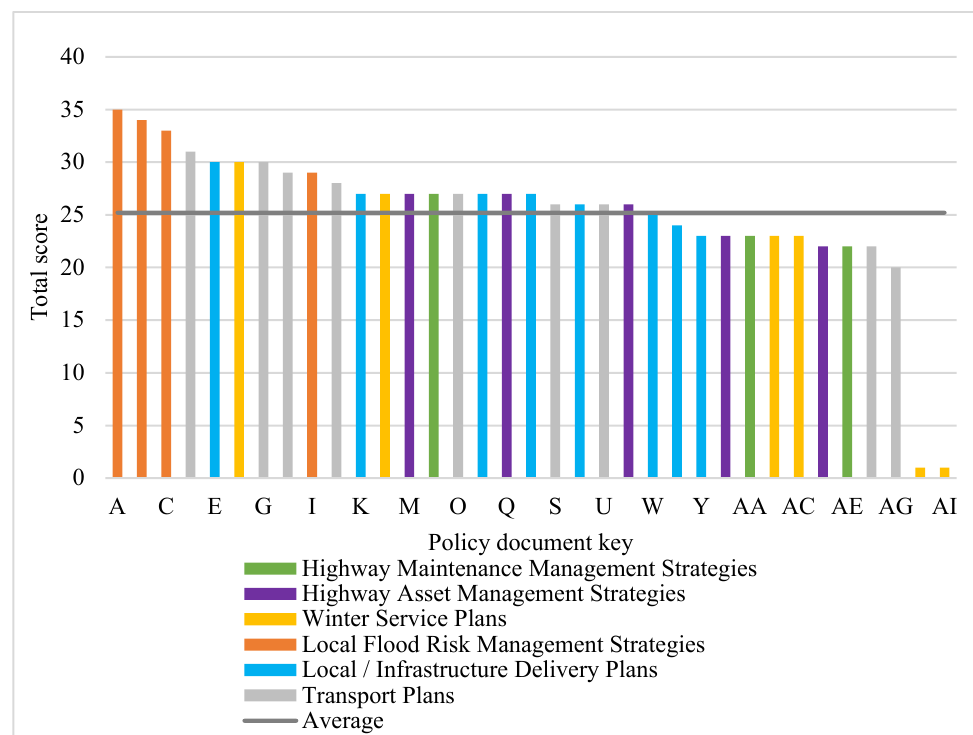
Figure 3. Type of policy document against total score.